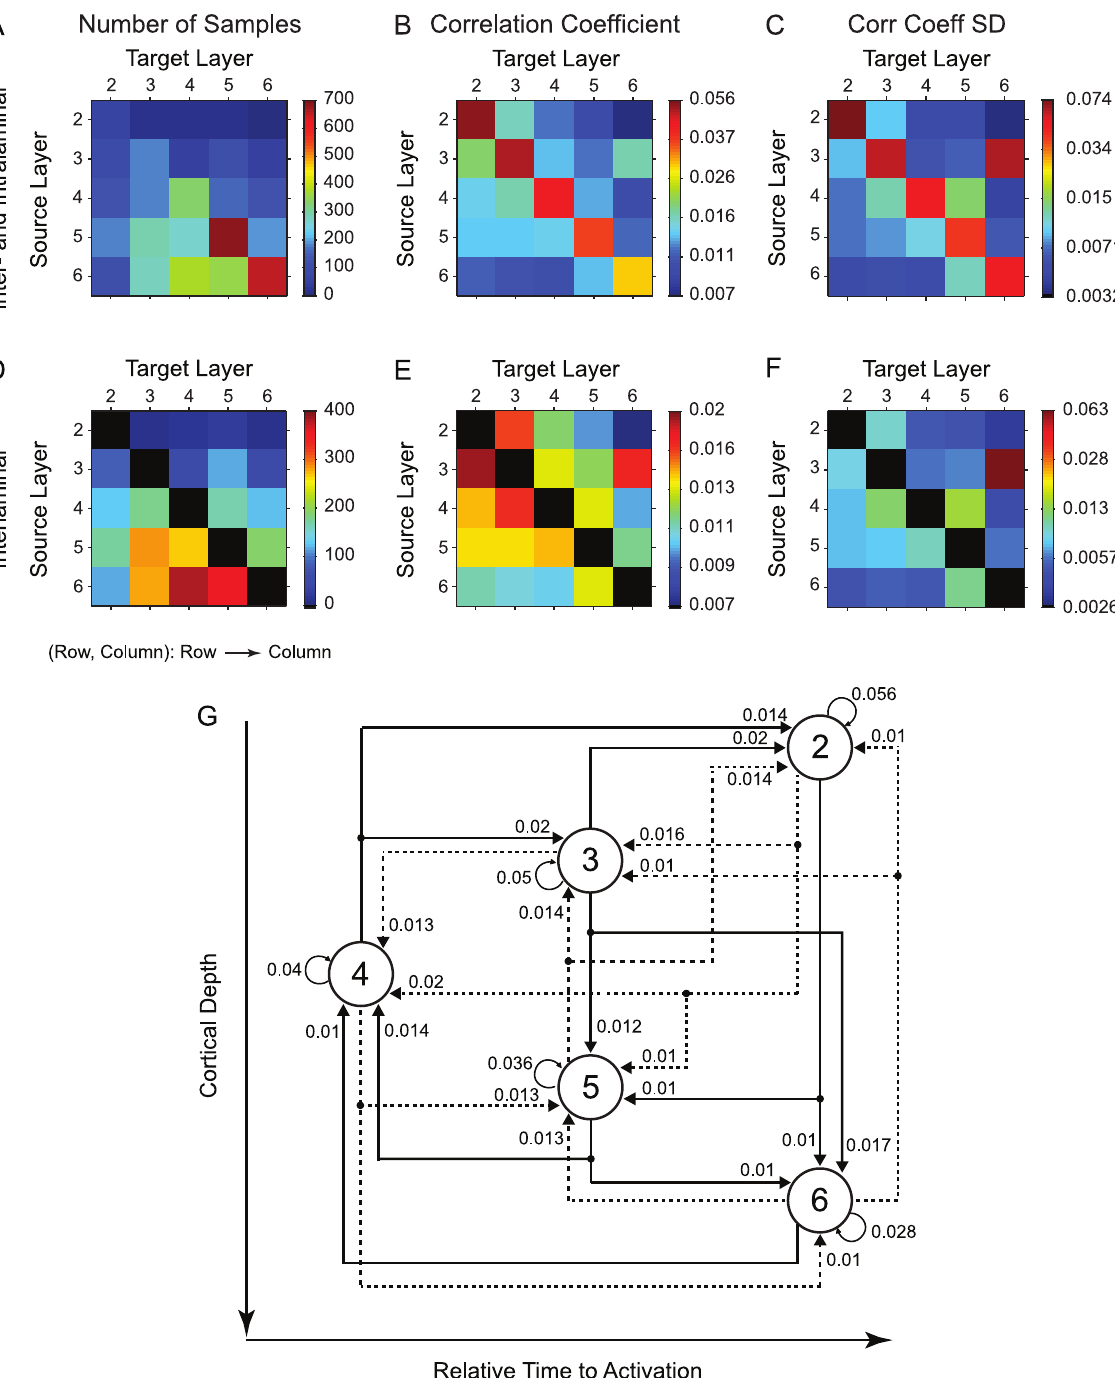
Figure 4. Summary of AI interlaminar connection strengths. For each neuron pair with a significant correlation we determined the direction of the connection and the correlation coefficient, or connection strength. (A) Number of pairs for all inter- and intralaminar data, grouped by laminar connection pattern. Each element in the matrix is in Row to Column form (Row, Column), which implies that the connection was from Row (= source layer) to Column (= target layer). The parameter value is indicated by the color. Element (4,3) implies the number of significant connections from layer 4 to layer 3 in our dataset. (B) Mean inter- and intralaminar connection strength, or correlation coefficient, for all significantly connected neuron pairs. (D, E) same as (A,B), with the intralaminar contributions removed to emphasize patterns of inter-laminar connections. (D) Number of connected pairs for each interlaminar combination. (E) Mean inter-laminar connection strength. (C, F) Standard deviation (SD) of inter- and intralaminar connection strength distributions, corresponding to the data in (B,E). (G) Layer connectivity diagram for the data in (B). Interlaminar and interlaminar connections are shown. Solid lines indicate feedforward connections in the auditory cortical microcircuit. Dashed lines indicate feedback connections. Values indicate the connection strengths from (B). Layers, indicated by circles, are vertically arranged to coincide with cortical depth. Layers are also organized horizontally to indicate the relative response time of each layer, as determined from latency analysis [37].